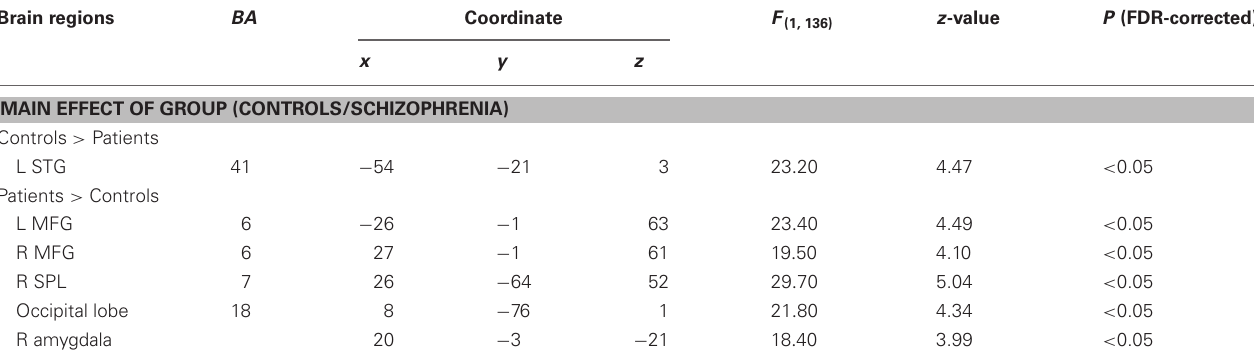
Table 2 | Peak coordinates ( x , y , z ) and their z -values of cerebral activation by full factorial design analysis with Group effect (controls and